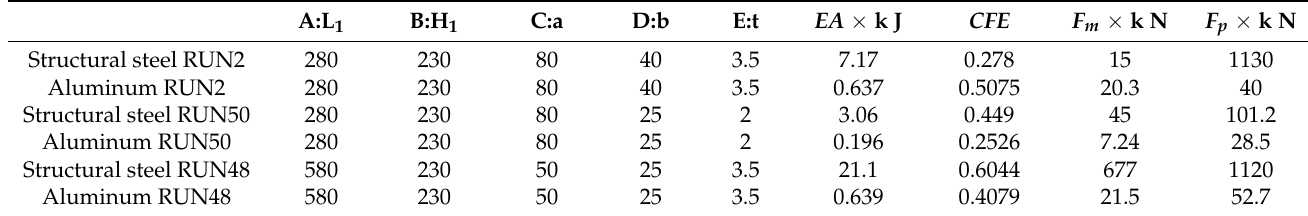
Table 4. Influence of different material properties on material crashworthiness.